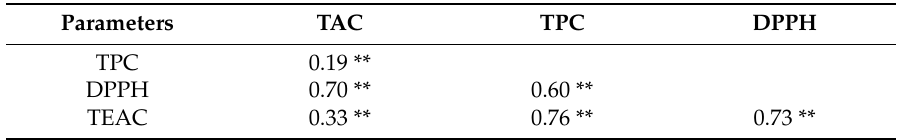
Table 3. Correlation coefficients (r) among the total anthocyanin content, total phenolic content and antioxidant capacity in the tassel of fifty waxy corn genotypes.